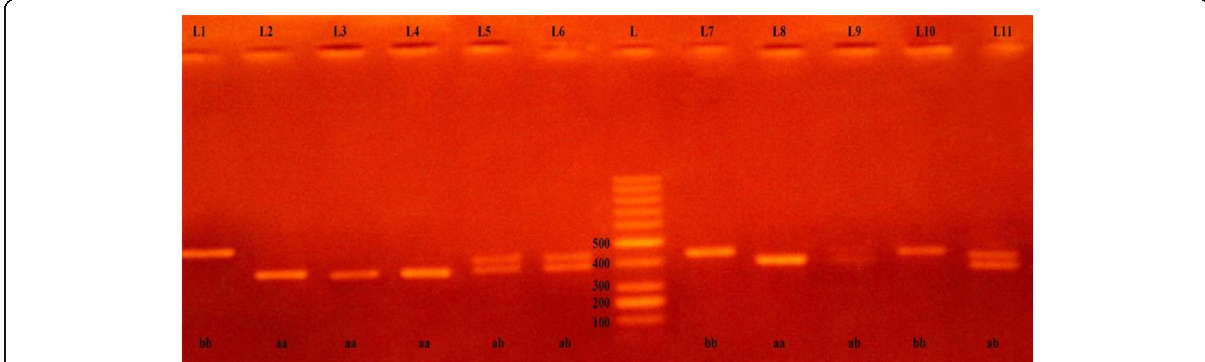
Fig. 3 Genotyping of the VNTR in intron 4 of eNOS gene (L = 100 bp ladder DNA marker) (bb: homozygous wild-type, ab: heterozygous- genotype and aa: homozygous-genotype).